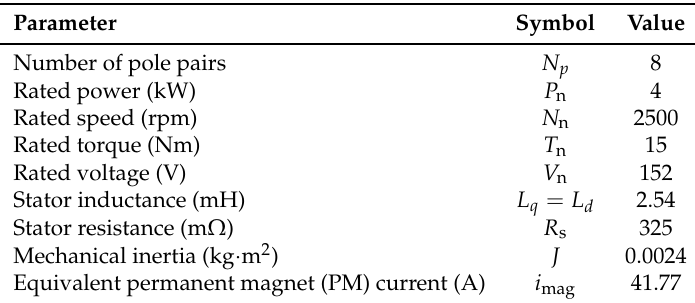
Table 1. Machine parameters.